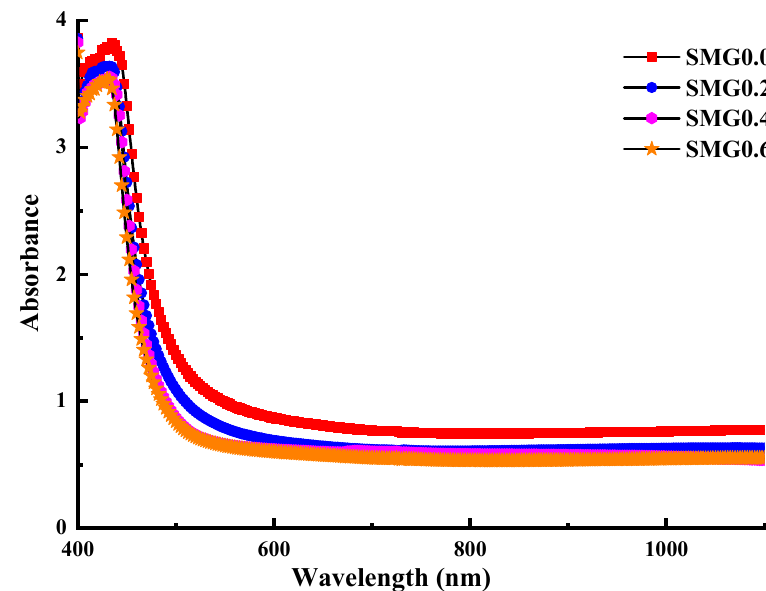
Figure 4. Spectra of Absorbance of glass samples.